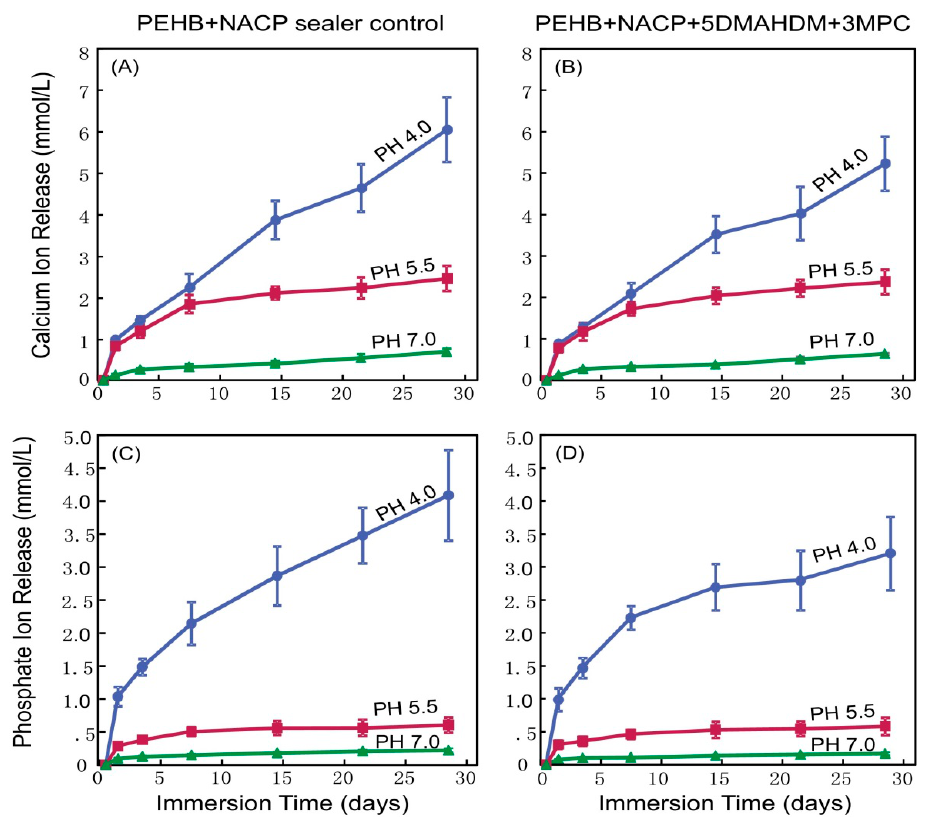
Figure 4. Calcium (Ca) and phosphate (P) ion release from endodontic sealers PEHB + NACP control and PEHB + NACP + 5DMAHDM + 3MPC. ( A , B ) Ca ion release, ( C , D ) P ion release. Ca and P ions concentrations increased with increasing time and decreasing pH. Adapted from [79] with